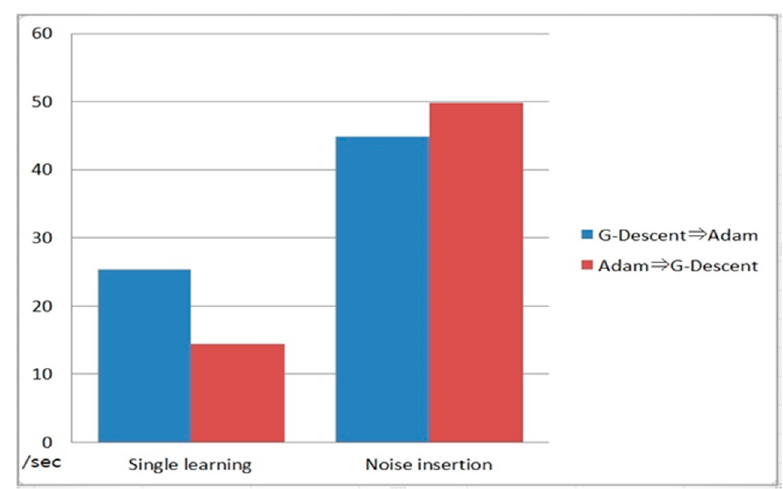
Figure 21. Comparison of learning time from single learning and from noise insertion.